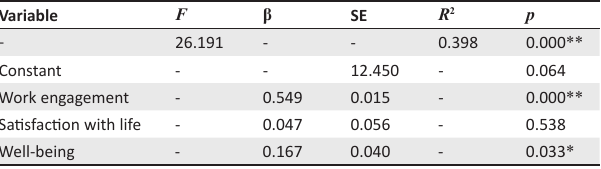
TABLE 4: Regression analysis with ‘affective organisational commitment’ as the dependent variable and ‘work engagement’, ‘satisfaction with life’ and ‘well-being’ as the independent